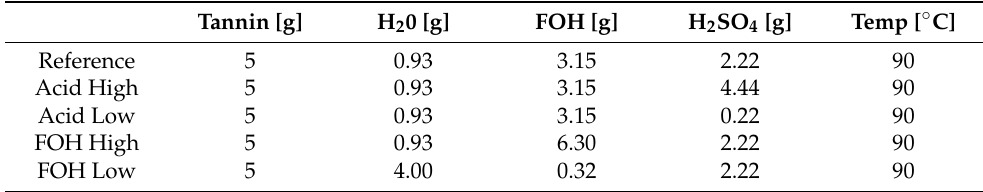
Table 2. Formulations of tannin-furanic